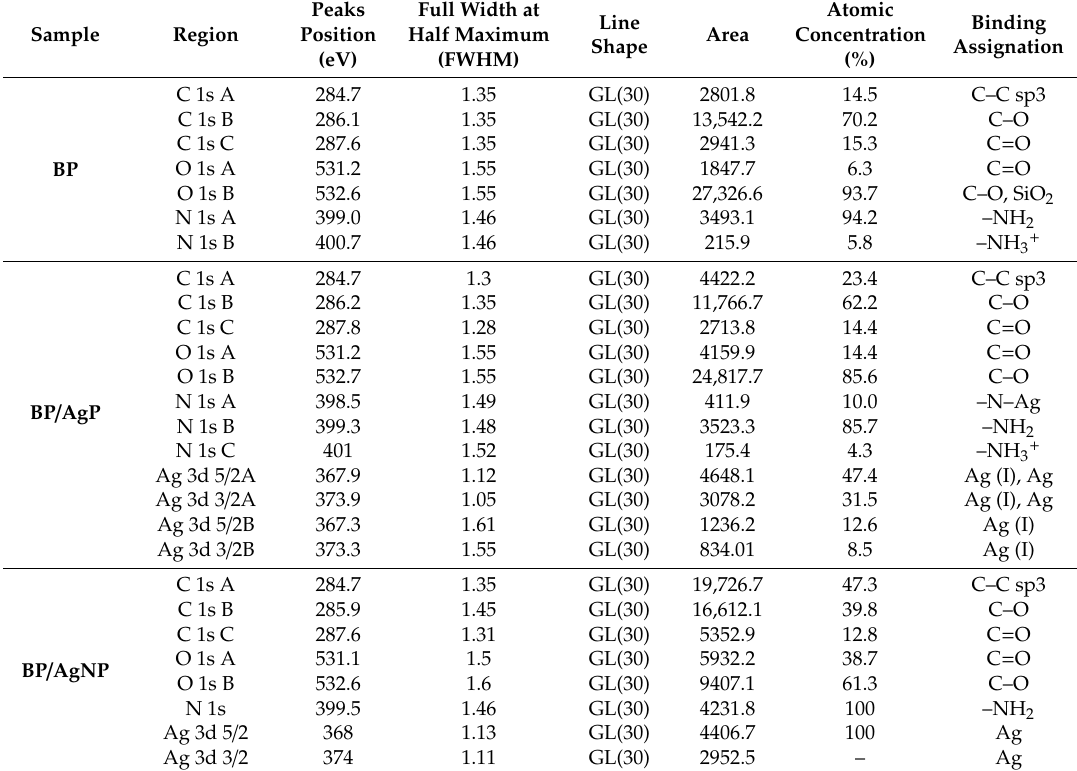
Table 2. Characteristics of XPS peaks for BP / AgP and BP / AgNP from high-resolution analysis and their